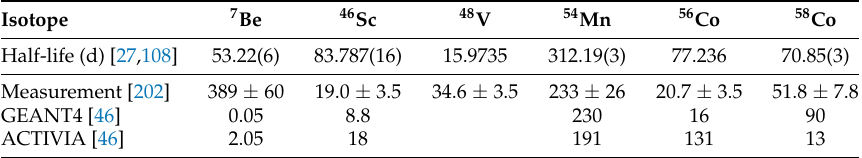
Table 8. Rates of production of long-lived radioisotopes induced in stainless steel at sea level. Measurements from Ref. [202] and different calculations are presented (see text). All numbers are expressed in atoms/kg/day.